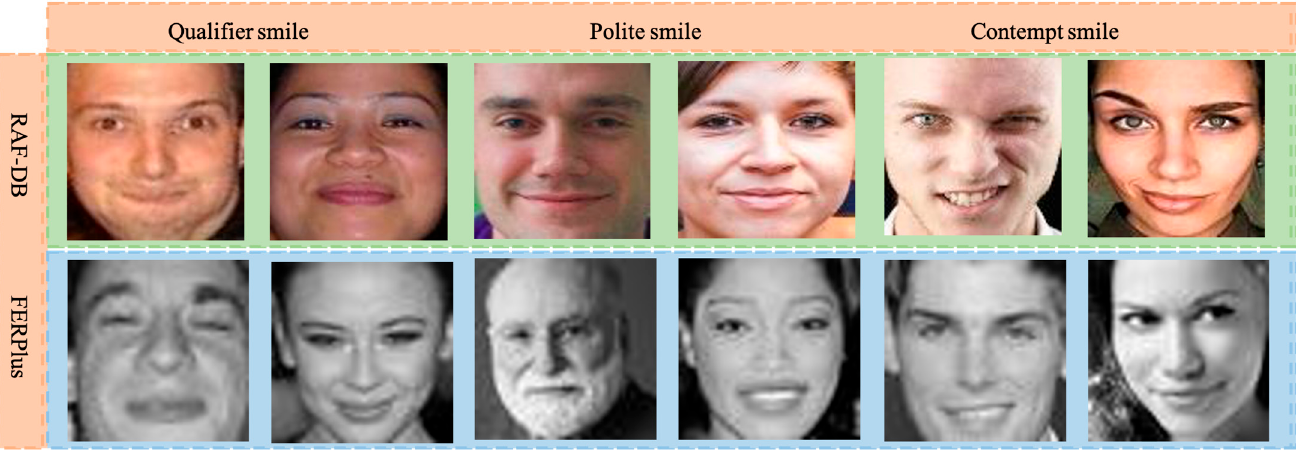
Figure 1. The green images are from the RAF-DB dataset (“happy” class and “non-happy” expres- sions), and the blue images are from FERPlus dataset (“happy” class and “non-happy” expressions).